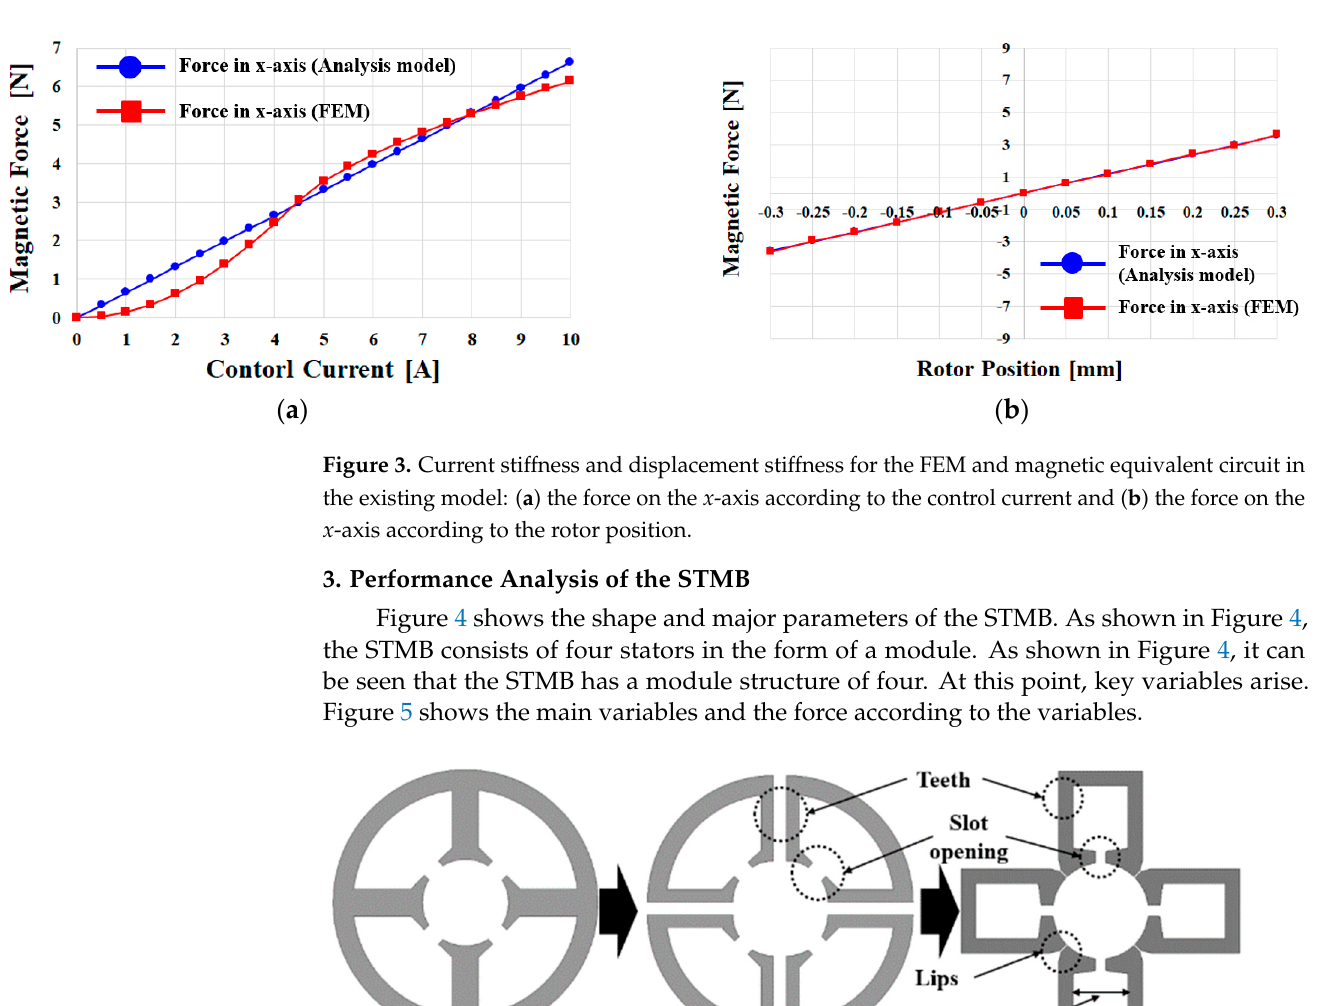
Figure 5. STMB main variable and force according to length: ( a ) STMB main variable and ( b ) force according to main variable length. The lips part is created by separated stator teeth in the STMB. These lips act as a major variable in the STMB. In addition, the slot opening length also acts as an important varia- ble. Figure 5b shows the force according to the two variable lengths. Both variables showed the same trend. As the length increased, the force decreased. When the lip air gap length increases, the force decreases because magnetic leakage flux occurs between the lips, and even when the slot opening length increases, the magnetic leakage flux occurs between the shoes and the magnetic force decreases. The slot opening length was selected as the minimum while securing the length for the winding wire to enter. The lips air gap length was selected to be 0.2 mm, and the slot opening length was selected to be 2 mm. At this time, the magnetic force according to the control current in the existing model and the STMB model is shown in Figure 6. Figure 6 shows the magnetic force for the control current of the existing model and the STMB model. The magnetic force for the control current of the conventional model and the STMB has a similar tendency. However, the STMB significantly reduced the stator weight by removing the back yoke by splitting the teeth on the existing stator. The stator weight of the previous model was 54.22 g, but the stator weight of the STMB was 36.15 g, a 33% reduction. Therefore, it is easy to reduce the weight by minimizing iron on the back yoke, and the fill factor is high because there is no restriction on winding. However, since a large leakage magnetic flux occurs between the shoes of the module, the force is reduced. The conventional magnetic bearing and the magnetic flux line of the STMB are shown in Figure 7. Leakage magnetic flux in conventional magnetic bearings occurs at the slot open- ings, teeth, and back yoke. However, the leakage magnetic flux of conventional magnetic bearings is small and can be ignored. However, the STMB generates a large leakage mag- netic flux from slot openings and lips. This is the leakage magnetic flux that occurs be- tween modules. Therefore, in order to reduce the leakage magnetic flux, it is essential to design the main variables. In order to compare the leakage magnetic flux generated from the STMB module, the STMB full model and one STMB module were compared. Both models are shown in Figure 8 and the force for the lip thickness is shown in Figure 9.